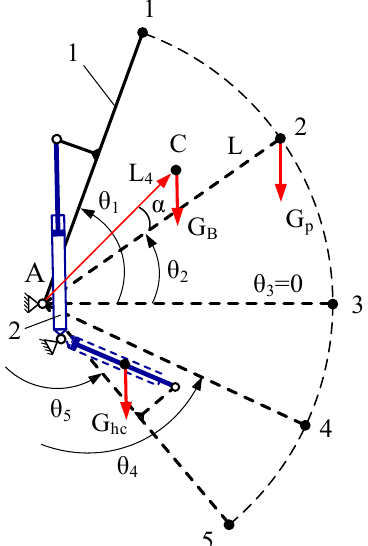
Figure 1. Graphical layout of the boom specific positions Another two loads applied to the boom are: 1) The weight of the boom G applied to its gravity center B whose position is determined by the vector with length L and angle α ; 2) The weight of the hydraulic cylinder 4 G , applied to its gravity center. In the current paper, hc